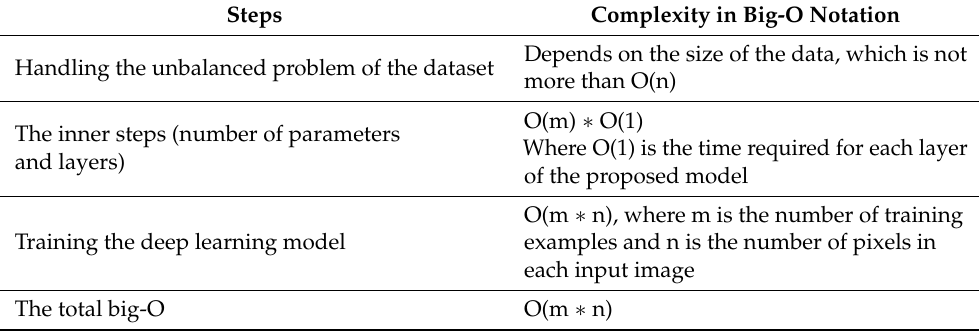
Table 9. Computational complexity required to accomplish the performance accuracy for training the proposed deep